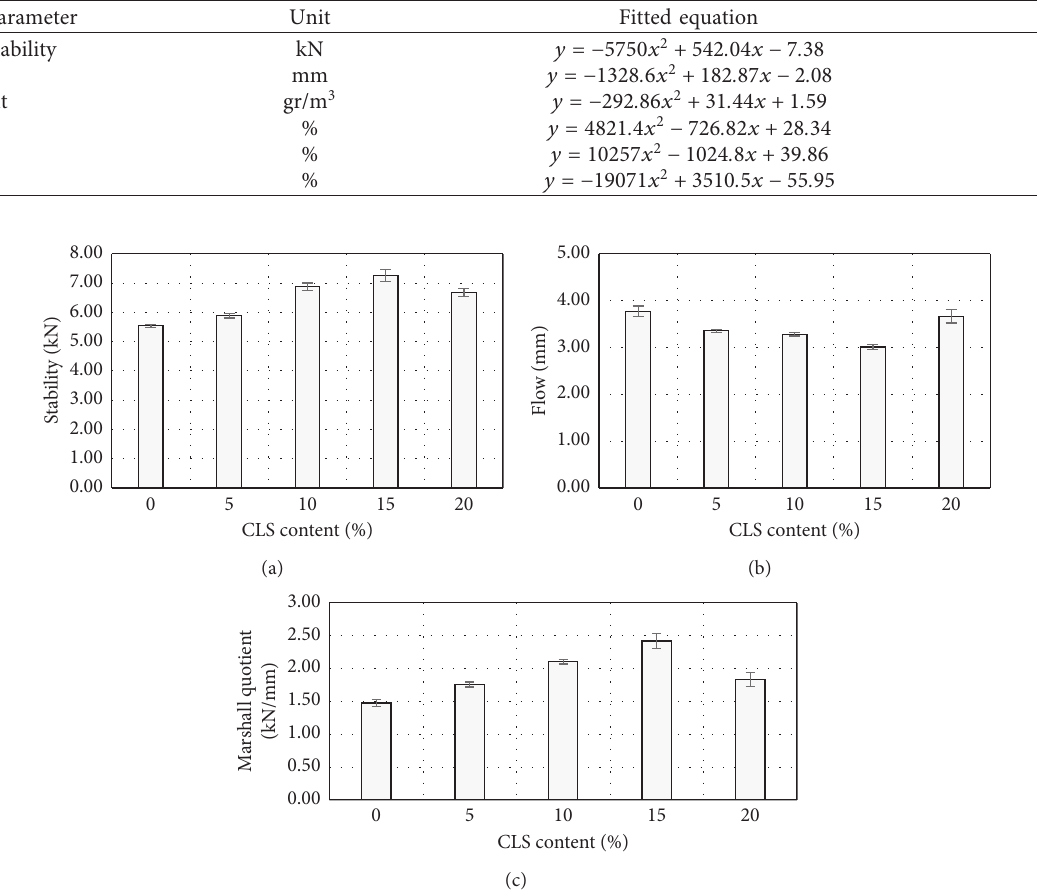
Figure 6: Marshall tests results: (a) Marshall stability outputs, (b) Marshall flow values, and (c) Marshall quotient